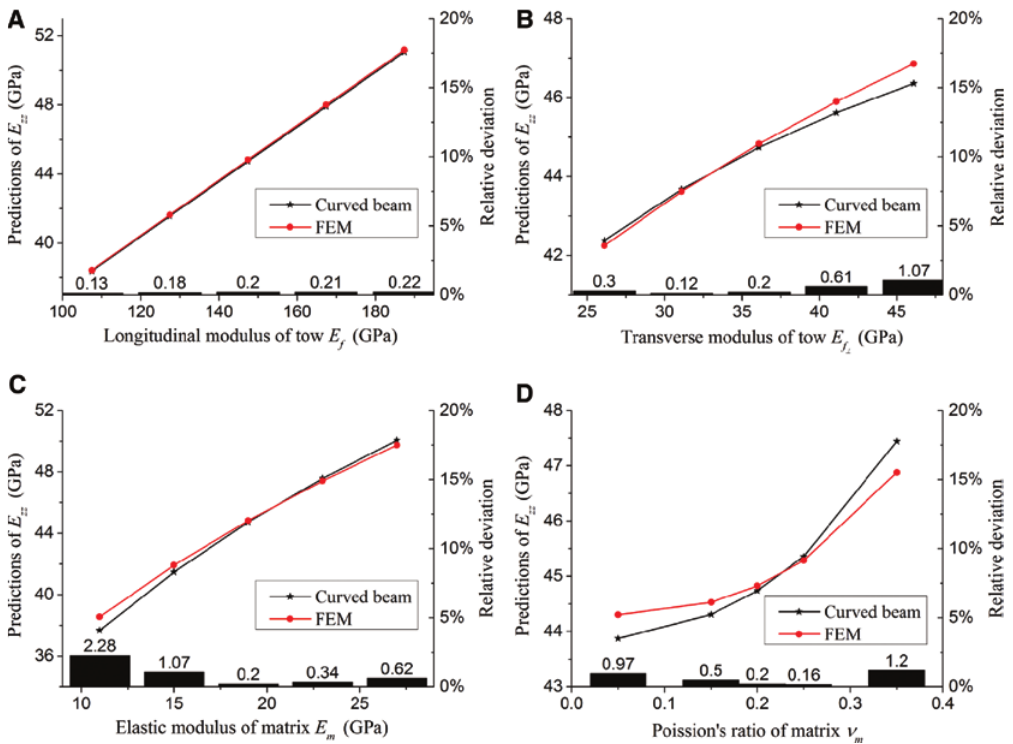
(lines with left axis) and relative deviation of curved beam model (column bars with right axis) from different Figure 17: The predicted E zz models with variant constitutive properties.